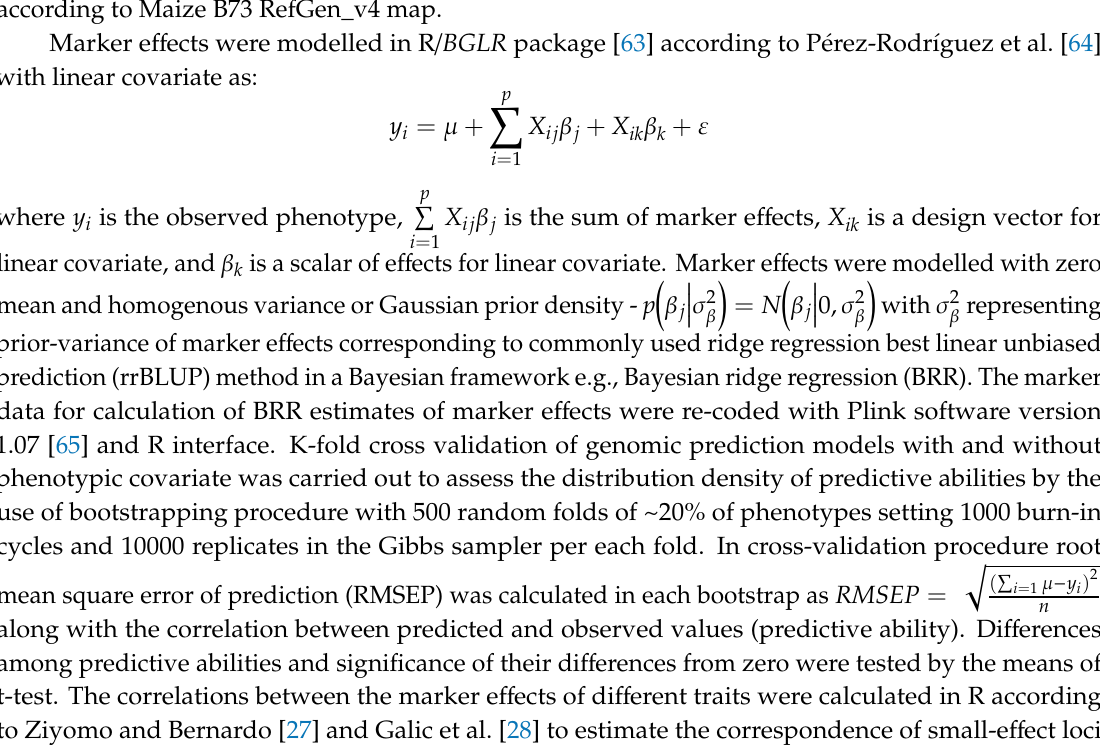
Supplementary Materials: The following are available online at http: // www.mdpi.com / 2223-7747 / 9 / 2 / 275 / s1. Table S1 (xlsx): Publicly available information for 109 maize inbred lines along with heterotic group designation (H group) and Q values from STRUCTURE analysis. Table S2: Results of association mapping without HKW as covariate (MLM + Q + K). Table S3: RMSEP values of genomic prediction models. Data (xlsx): All data needed to reproduce the results presented in the manuscript (filtered GBS markers, phenotypic data with fixed covariates and